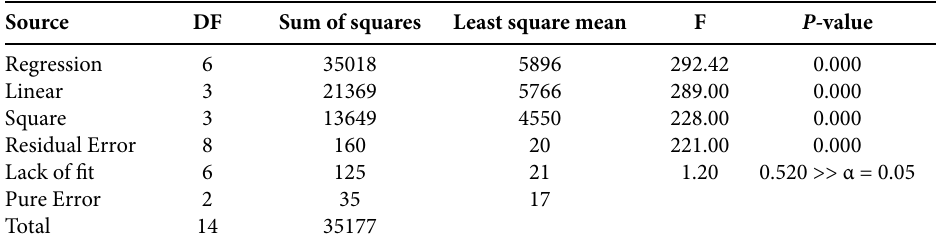
Table 3. ANOVA for the obtained model of RSM (Eq. 3).